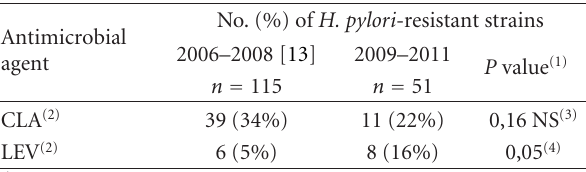
Table 2: Comparison of resistance of H. pylori strains to clarithro- mycin and levofloxacin between 2006–2008 [13] and 2009–2011.